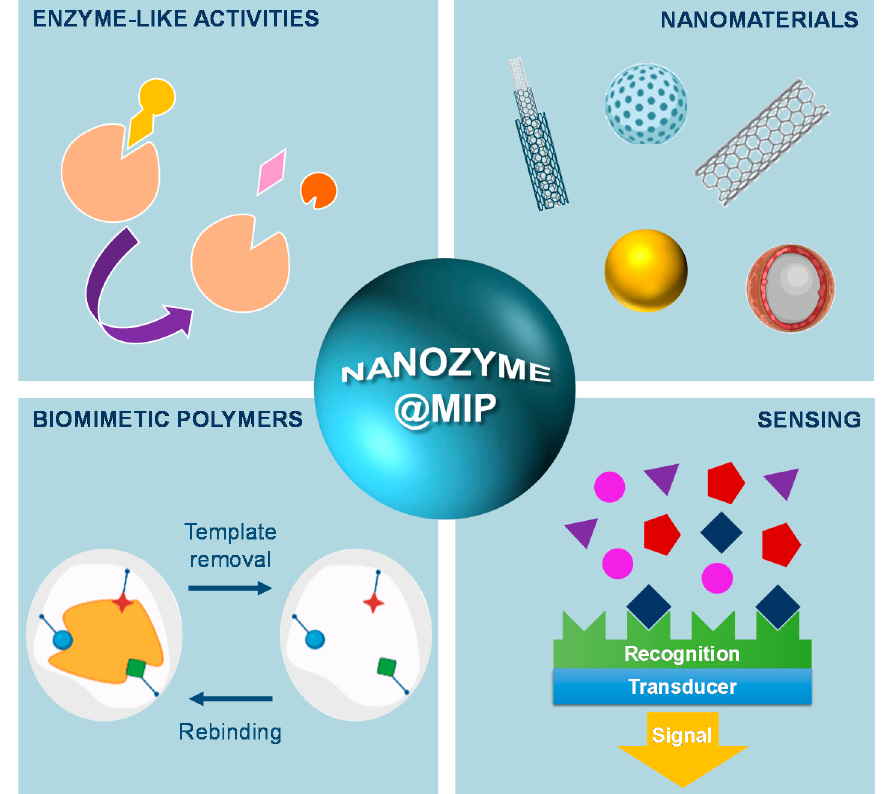
Figure 12. Schematic representation of the nanozyme action in combination with MIP materials. Once they have surpassed the current limitations and achieved the enhanced catalytic activity and specificity, imprinted nanozymes can be incorporated in portable, low-cost, and time-saving assays for novel point-of-care applications. These point-of-care applications linked to low-cost devices that rely on synthetic materials are a huge opportunity for developing new tools that allow global efforts and alliances in combating the current and future pandemics, as well as screening for chronic diseases, allowing earlier detection and earlier medical action, to improve treatment outcomes.